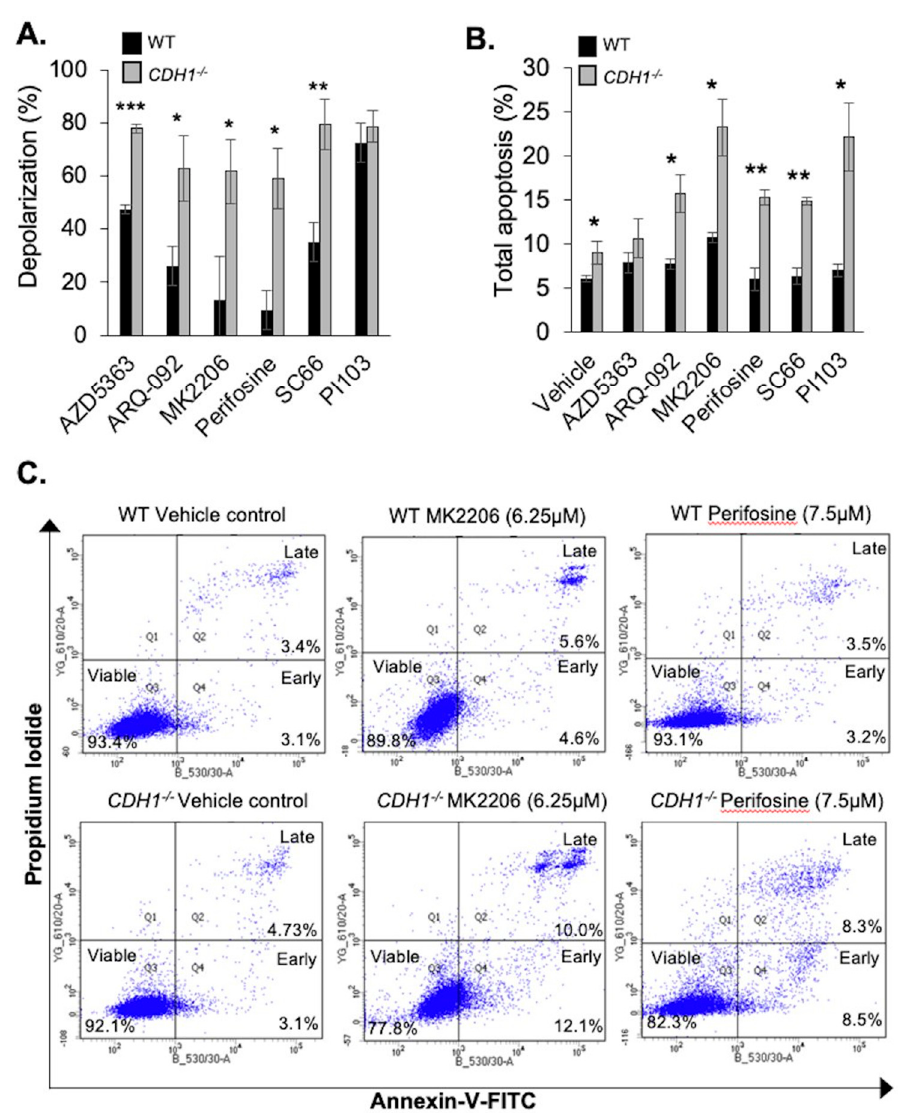
Figure 2. Inhibition of AKT preferentially primes CDH1 -null cells for apoptosis. ( A ) Mitochondrial membrane depolarisation in MCF10A-WT and CDH1 − / − cells after 16–20 h treatment with AKT inhibitors. ( B ) Total apoptosis (Annexin-V-FITC and propidium iodide positive cells) detected by flow cytometry after 72 h drug treatment. ( C ) Representative histograms of MCF10A-WT and CDH1 − / − cells stained with Annexin-V-FITC and propidium iodide and analysed on BD Fortessa flow cytometer. (For all graphs, error bars = SEM; ns = p > 0.05, * = p < 0.05, ** = p < 0.01, *** = p < 0.001; n ≥ 3 independent biological replicates; unpaired two-sided t